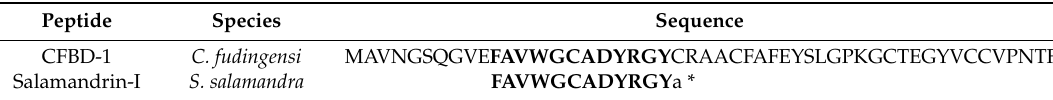
Table 1. Salamandrin-I structural similarity with the CFBD-1 sequence. Bold letters represent identical amino acid